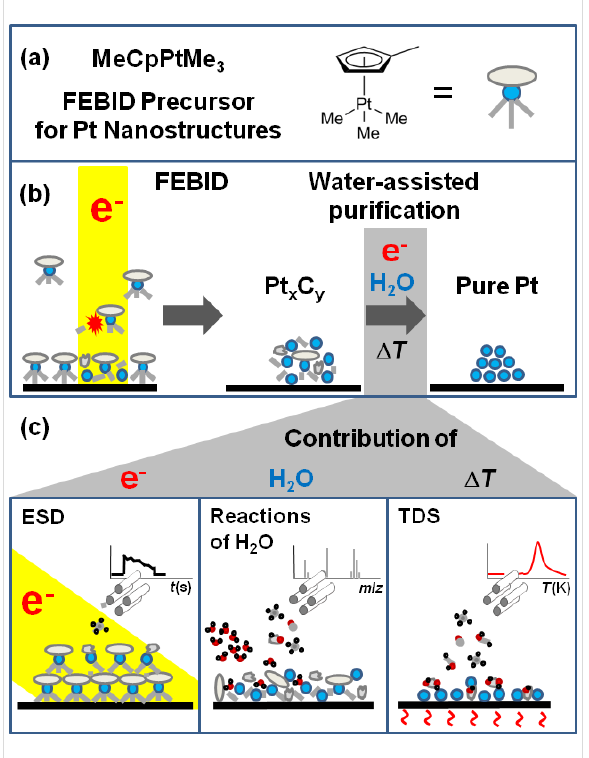
Figure 1: Molecular structure of the FEBID precursor trimethyl(methyl- cyclopentadienyl)platinum(IV) (MeCpPtMe 3) (a), schematic of the FEBID process and the subsequent water-assisted purification [12] of a deposit produced from MeCpPtMe 3 (b), and mass spectrometric